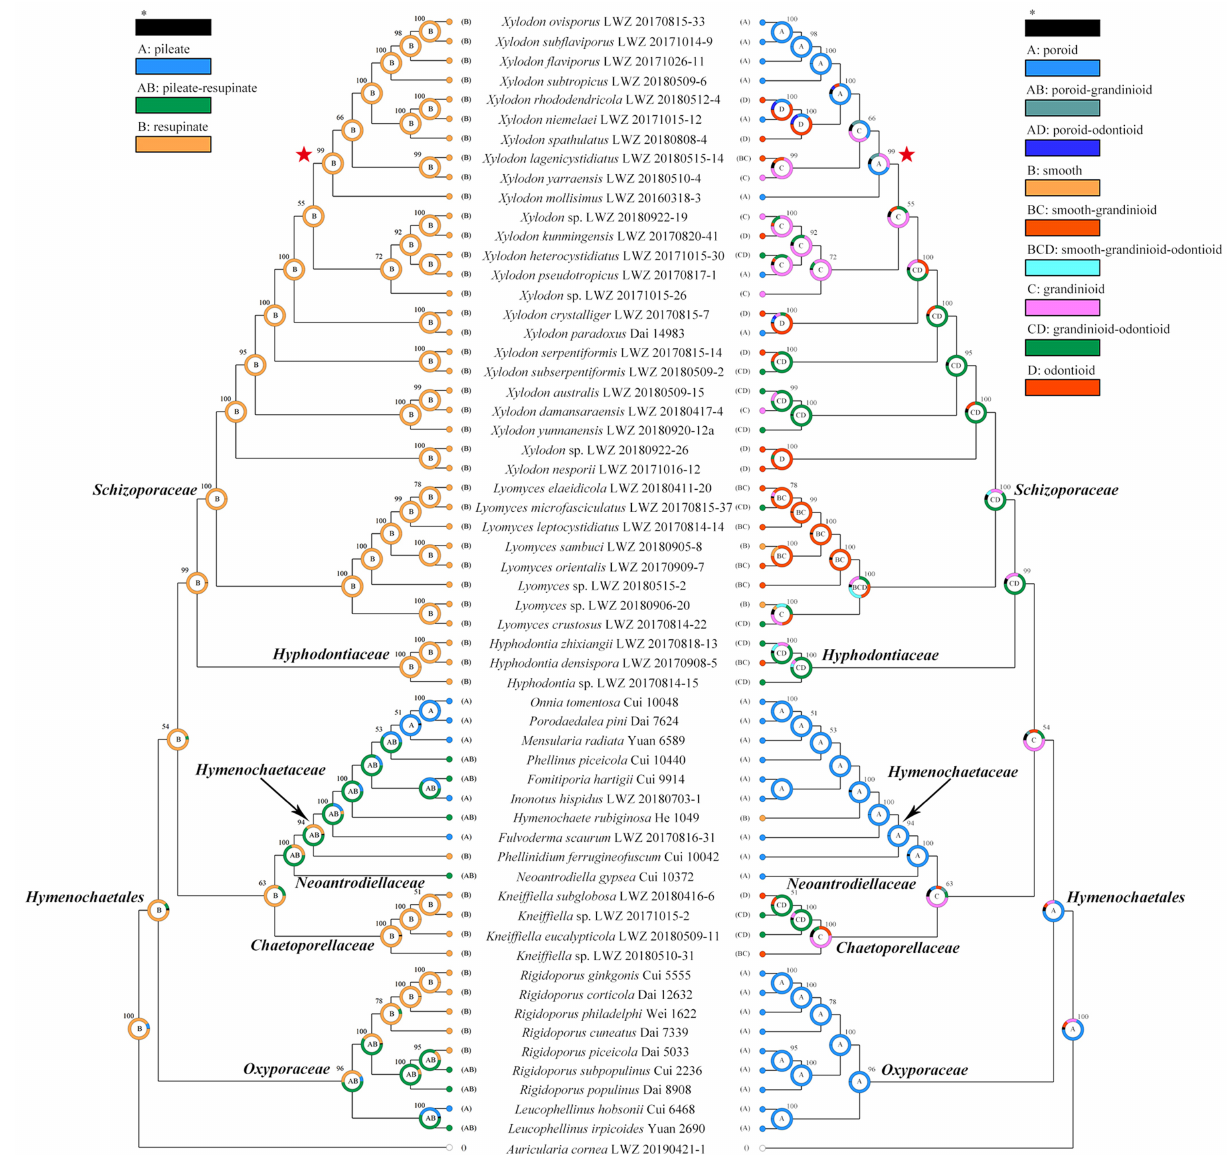
Figure 7. Trait evolution of basidiocarps within Hymenochaetales . The mirrored consensus tree was generated by the Bayesian inference algorithms using BEAST, while the trait of a pie chart at each node was evaluated using RASP under the Bayesian Binary MCMC model. The trait represented by each color and letter in the pie chart is indicated in the upper-left for the left part and upper-right of the right part. The lineage for each family is indicated at the nodes along with the pentagram mark for assisting